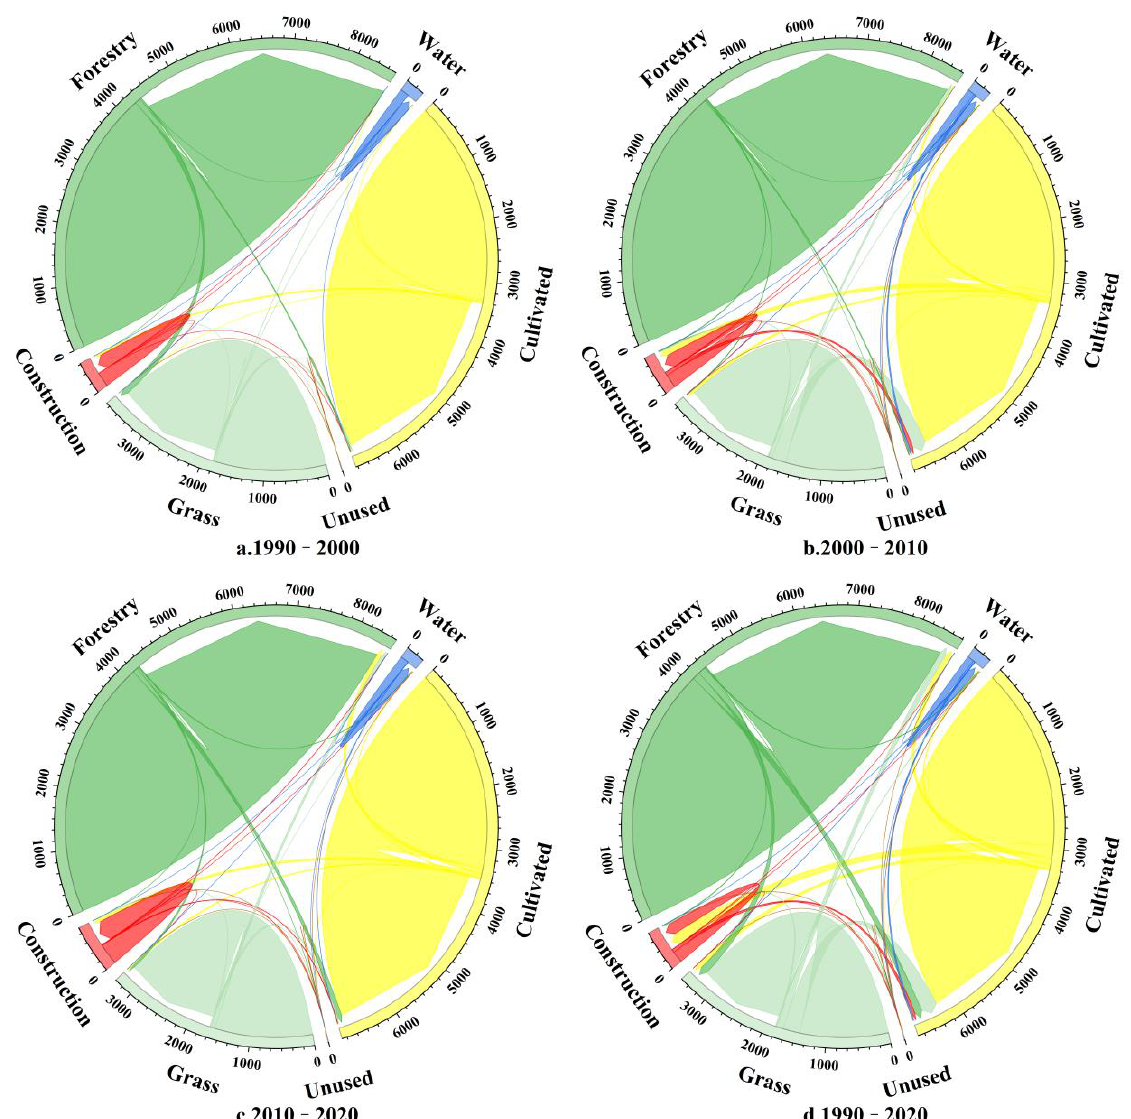
Figure 7. Variation in land use type during different periods.